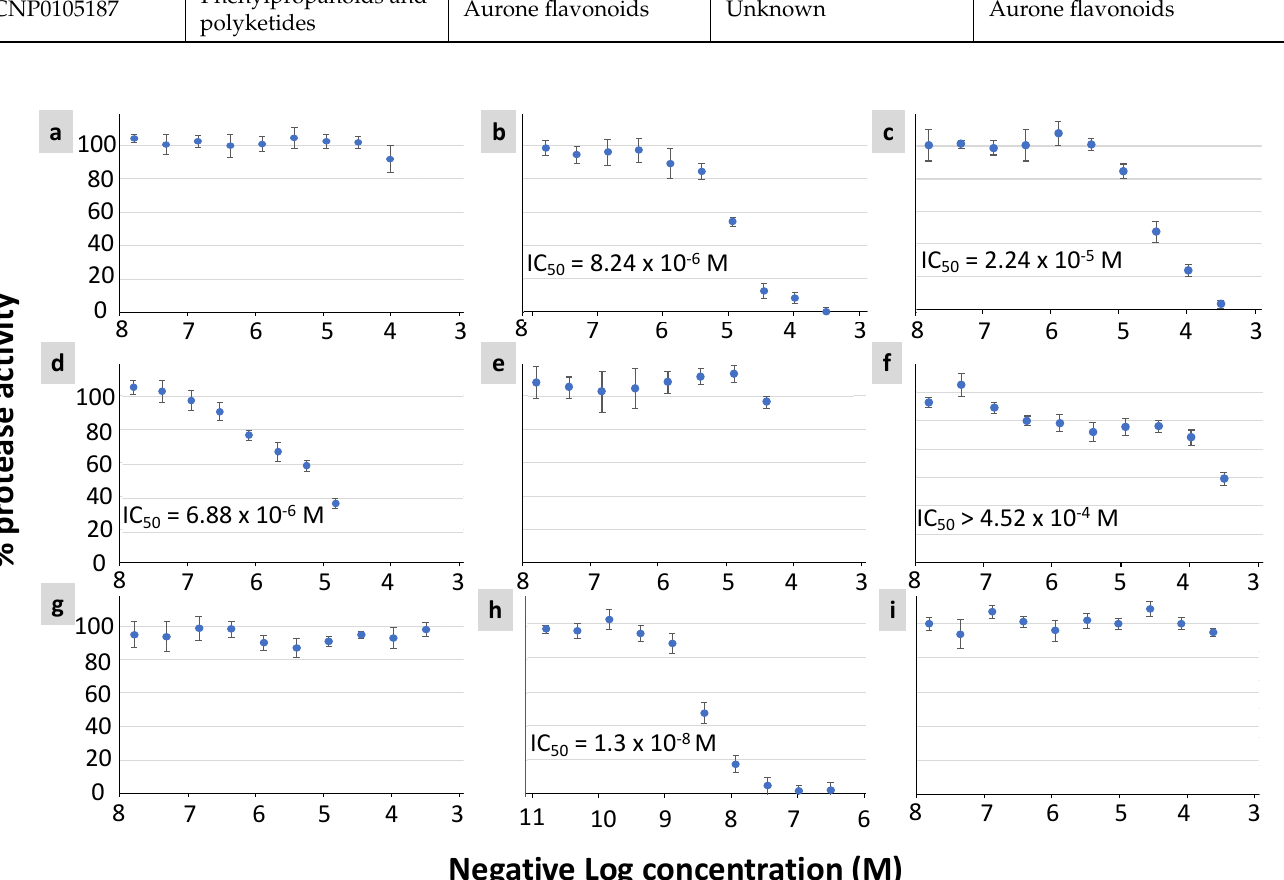
Figure 5. The results of in vitro protease inhibition assay of the seven NP ligands against the SARS-CoV-2 M pro protein. The y -axis shows the percent M pro protease activity. The x -axis shows the negative log 10 transformed molar concentration of the NP ligands. A 10-dose three-fold serial dilution has been applied to the original 200 uM NP ligand. Some data points exhibited fluorescent backgrounds and were excluded from curve fitting. ( a ) CNP0403473, ( b ) CNP0381522, ( c ) CNP0375828, ( d ) CNP0061237, ( e ) CNP0402005, ( f ) CNP0366487, ( g ) CNP0105187, ( h ) GC376 (positive control), ( i ) DMSO (negative control). The IC50 values are provided for the four NPs and the positive control (subfigures b , c , d , f , h ).